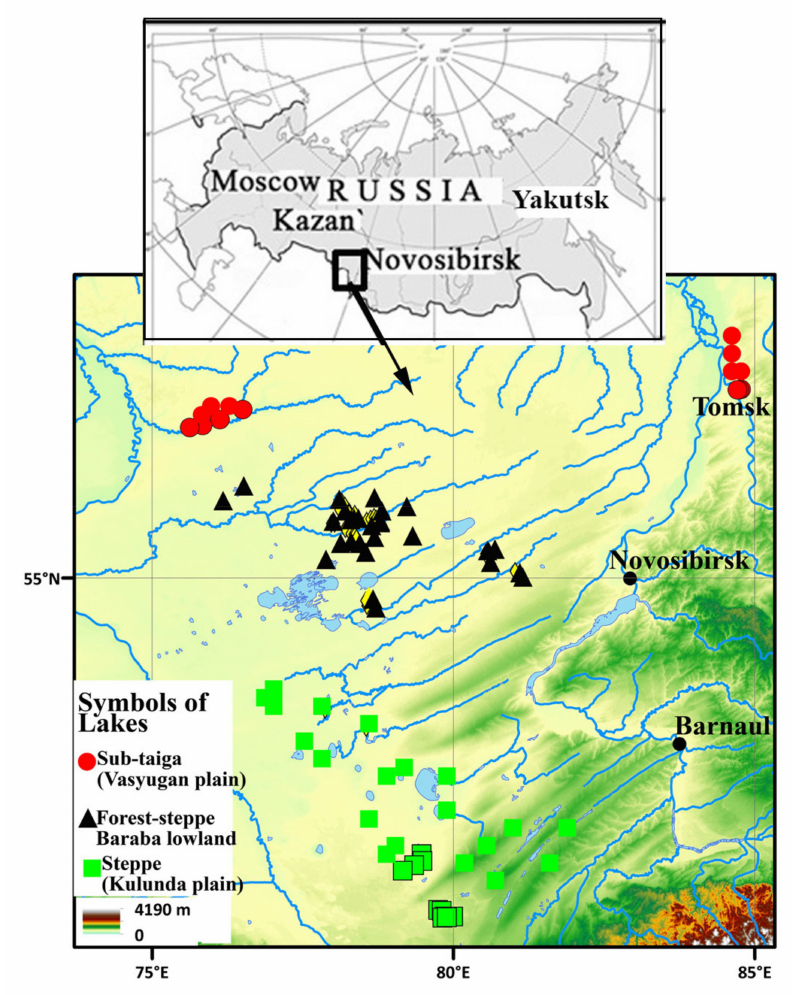
Figure 1. The layout of the studied small lakes in the south of Western Siberia [24] with